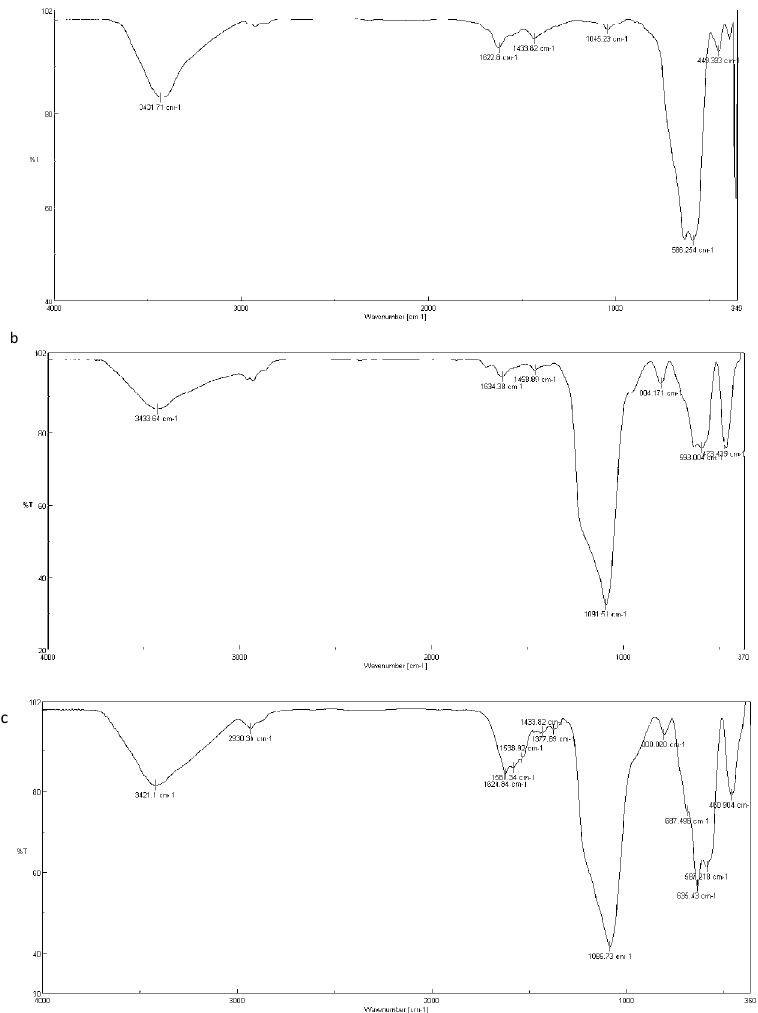
Fig. 1: Comparison of the the FT-IR spectra of (a) Fe